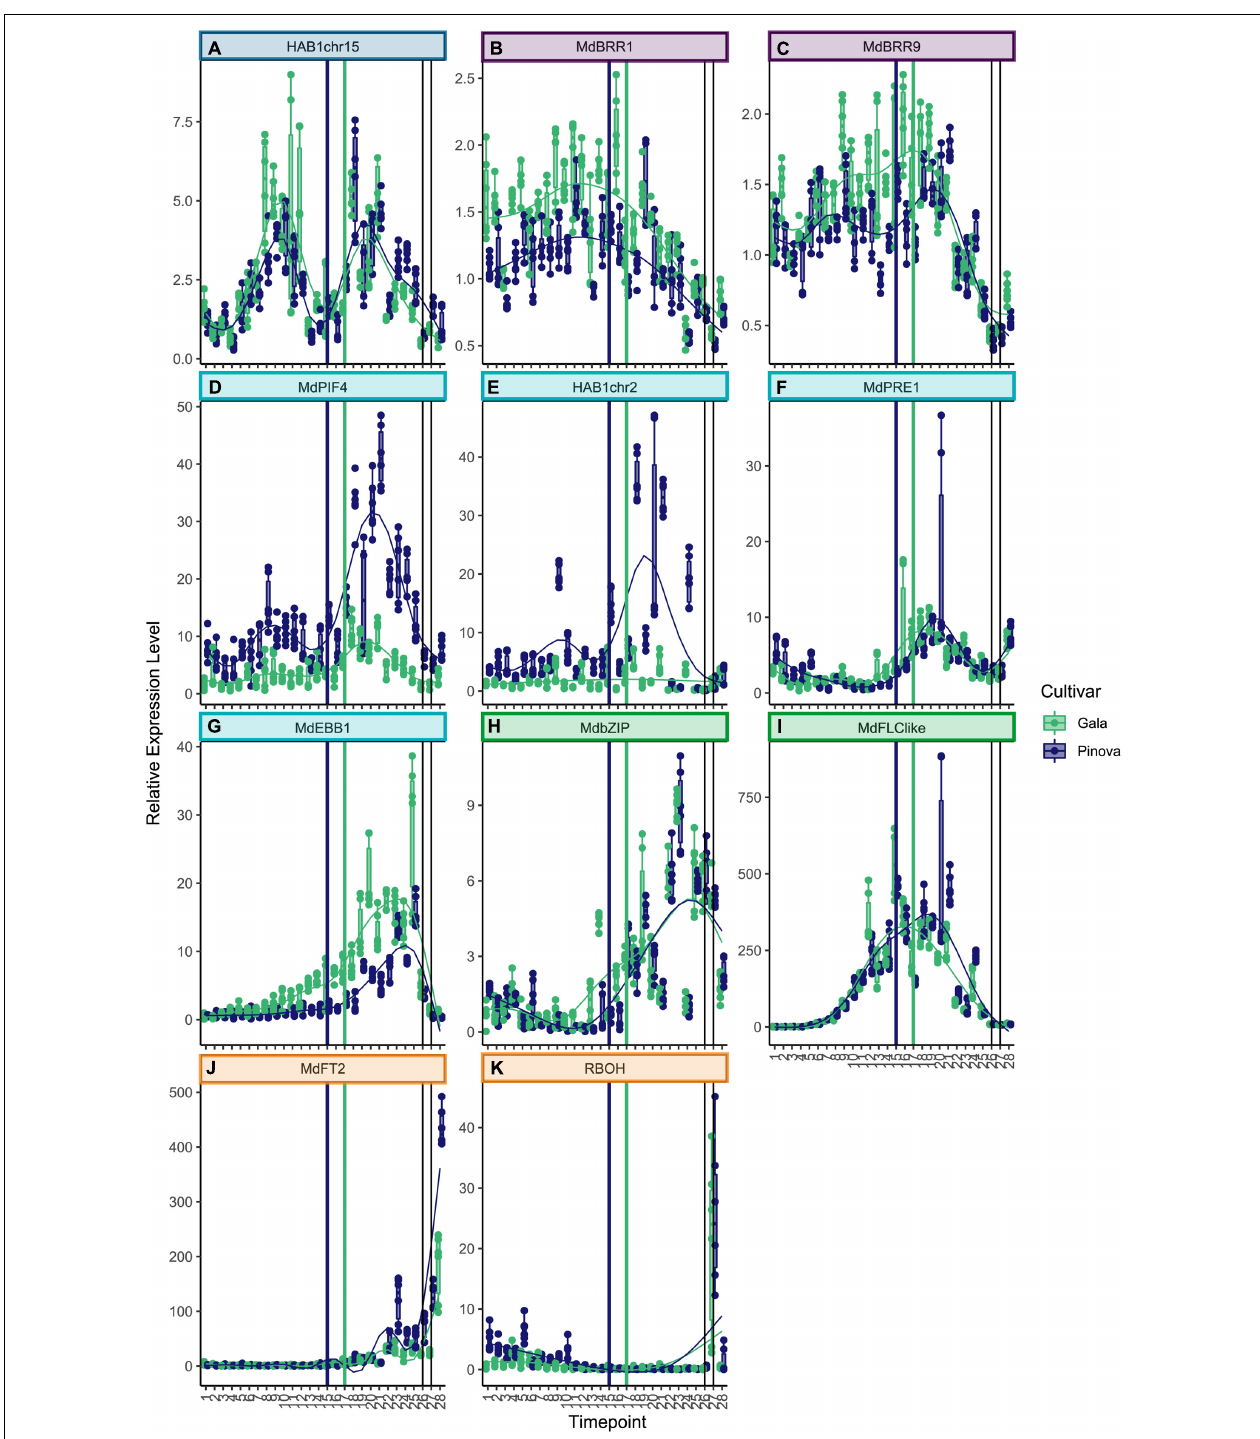
FIGURE 3 | Expression patterns of genes belonging to clusters 2–6. (A) HAB1chr15 showed two similarly strong peaks of expression, on December 6 and February 14, and the local minimum was on January 10, 1 week before the ecodormancy to endodormancy transition. (B) MdBRR1 and MdBRR9 (C) were expressed broadly across dormancy and declined before bud break. (D) Expression of MdPIF4 as well as for HAB1chr2 (E) showed two peaks of which the first peak was lower than at the second peak, and ‘Pinova’ expression levels were higher compared to ‘Gala.’ (F) The expression of MdPRE1 was low during endodormancy and showed a maximum of expression on February 7 and 14. (G) The expression levels of MdEBB1 and MdbZIP peaked slightly later, on March 7 and March 14 (H) . (I) MdFLC-like was expressed broadly and it peaked later in ‘Pinova’ compared with ‘Gala.’ (J) RBOH and MdFT2 (K) were not expressed during dormancy; however, they were strongly induced on bud break. The color scheme is identical to the one in Figure 2 .